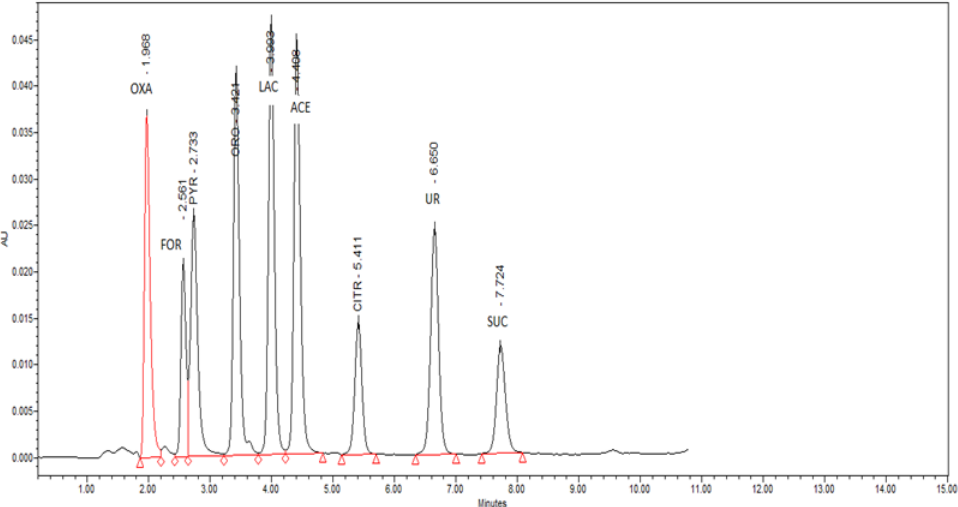
Figure Figure 1. Chromatogram of organic acid standards — OXA — oxalic acid; FOR — formic acid; PYR — pyruvic acid; ORO — orotic acid; LAC — lactic acid; ACE — acetic acid; CITR — citric acid; UR — uric acid; SUC — succinic acid; AU — absorbance units.